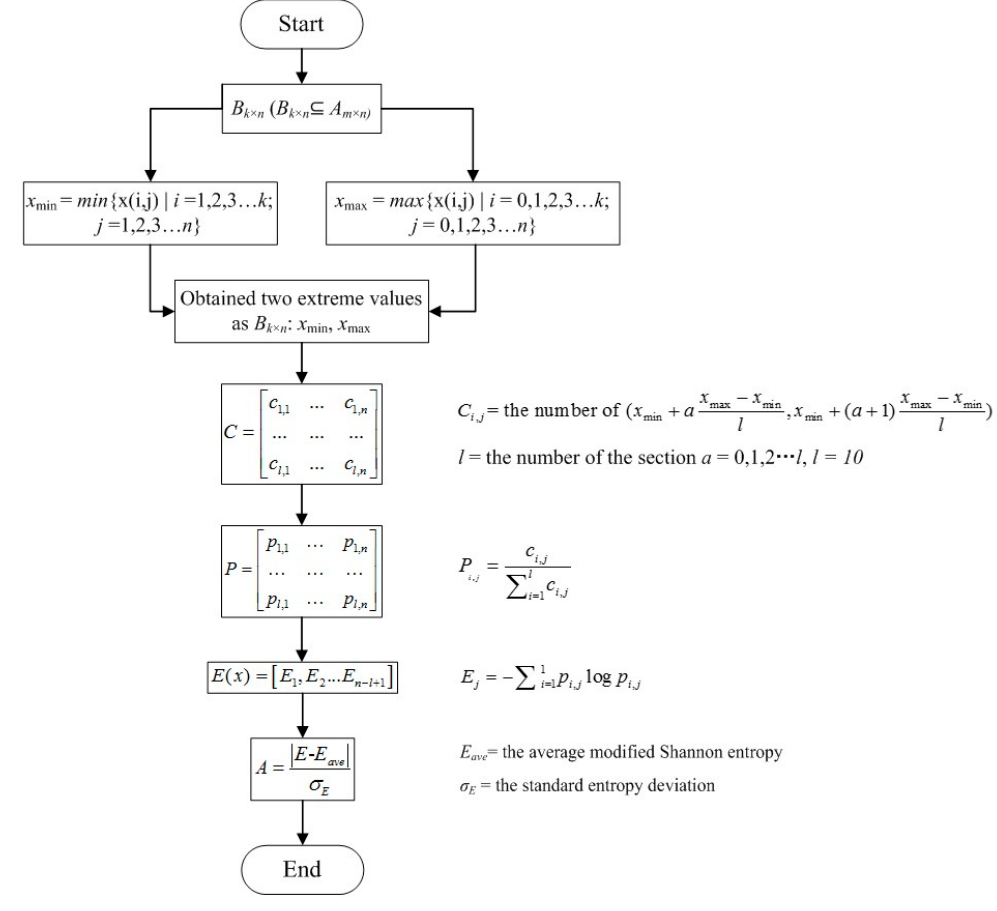
Figure 1. The diagnosis and prognosis algorithm flowchart.